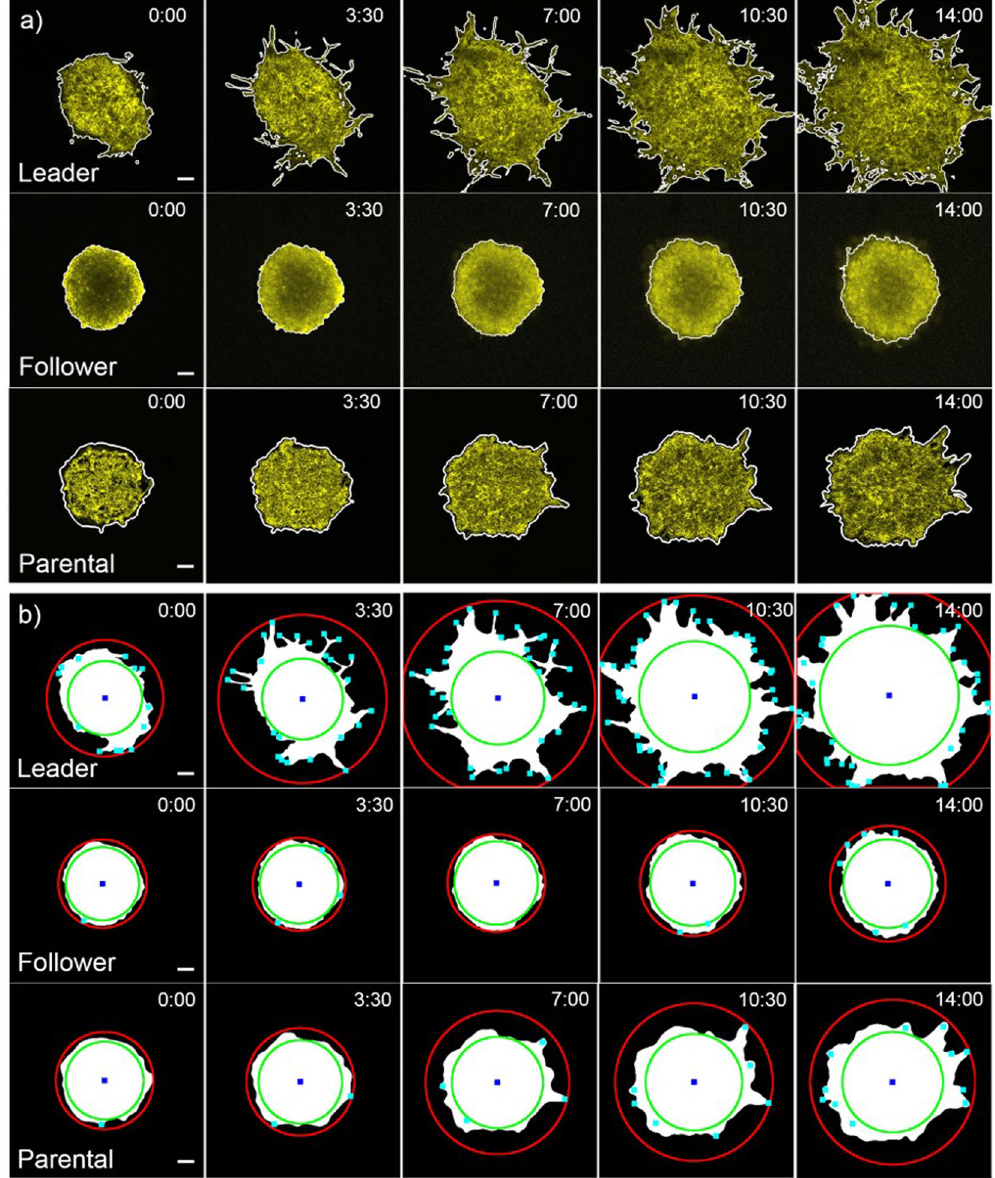
Figure 2. Distinct patterns of dynamic features. ( a ) 3-dimensional graphcuts segmentation results. The white outlines are segmented boundaries for leader, follower and parental spheroids at different time points (Hour: Minute). Scale bars are 100 μ m. ( b ) Feature extraction results. The red circles are invasive radius; green circles are core radius; blue squares are centroids and cyan dots are branch points for leader, follower and parental spheroids at each time points (Hour: Minute). Scale bars are 100 μ